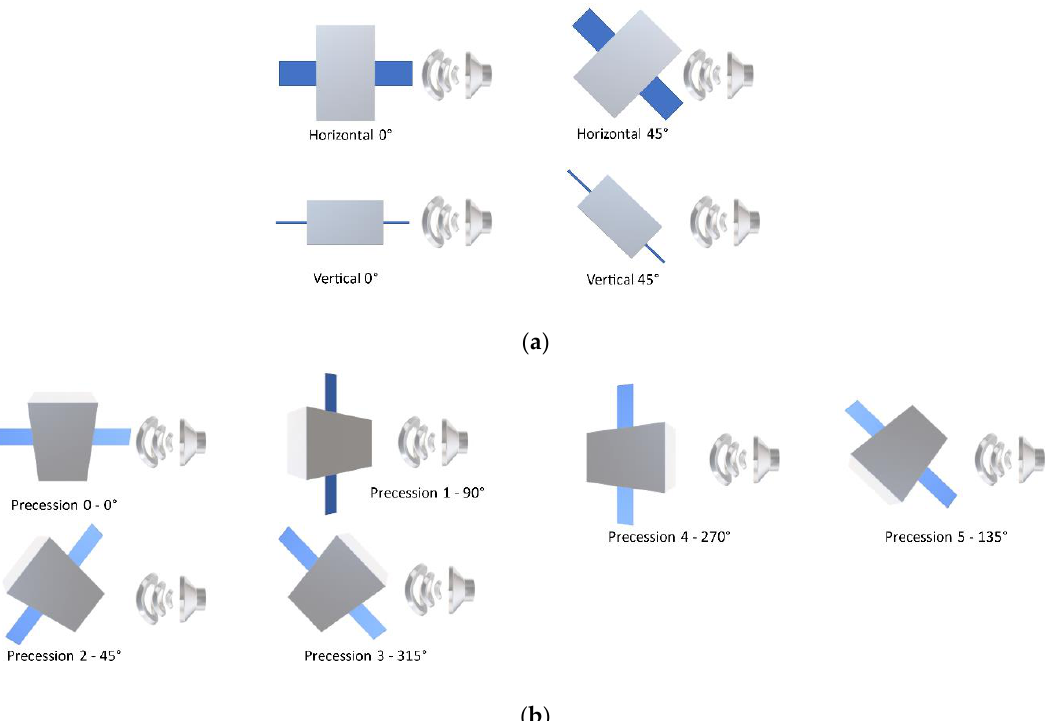
Figure 9. Parallelepiped with appendices positioning in respect to the wave incidence direction. ( a ) Horizontal and vertical positions; ( b ) precession positions.